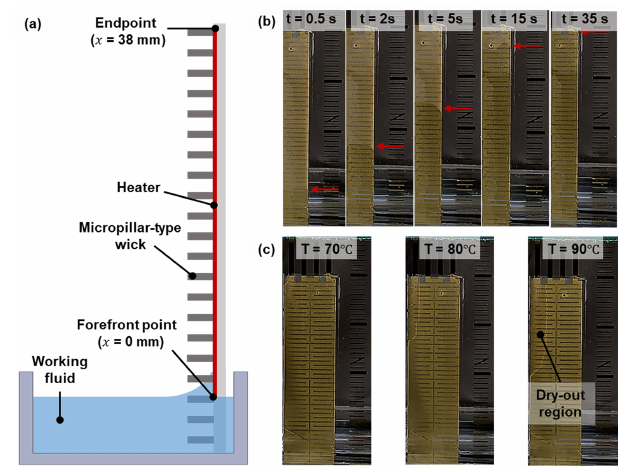
Figure 5. (a) Schematic of the capillary rise experimental setup. (b) Selected video frames from the rise of the working fluid using the micropillar-type wick. (c) The dry-out region formation as the surface temperature increased.